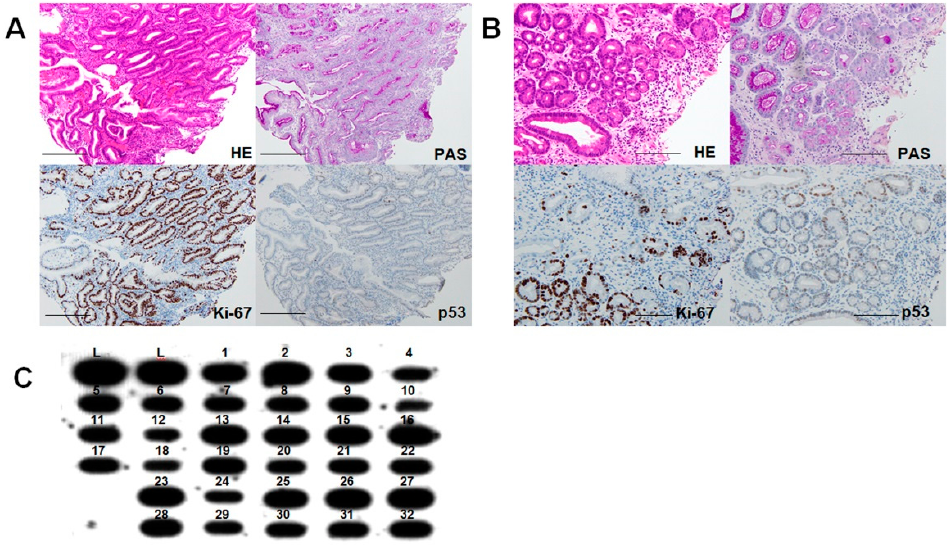
Figure 3. Dysplastic metaplasia in gastric mucosa. ( A ) Histological appearance of low-grade DM (Case 1 in Table 3). ( B ) Histological appearance of high-grade DM (Case 12 in Table 3). ( C ) TV by slot blot hybridization using (TTAGGG) 4 probe. HE, hematoxylin & eosin staining; PAS, periodic acid-Schiff staining; DM, dysplastic metaplasia; TV, telomere volume; L, lymphocytes.